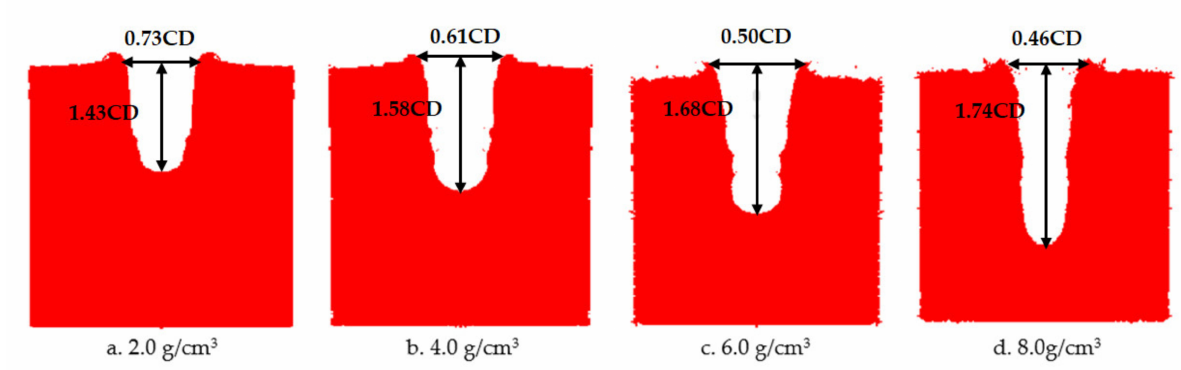
Figure 18. Damage effect of different reactive charge liner densities penetrating a steel target.